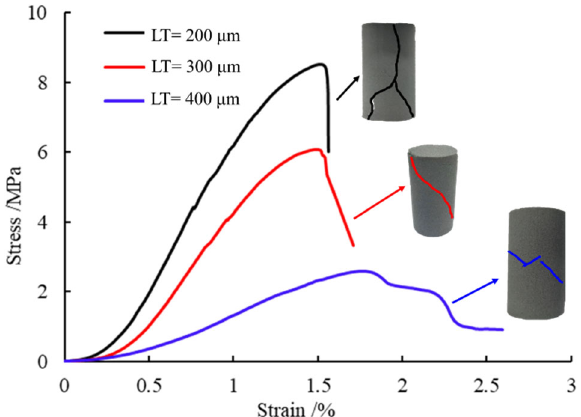
Figure 12. Comparison of stress–strain curves and failure patterns of the 3DP rocks printed with different LTs.